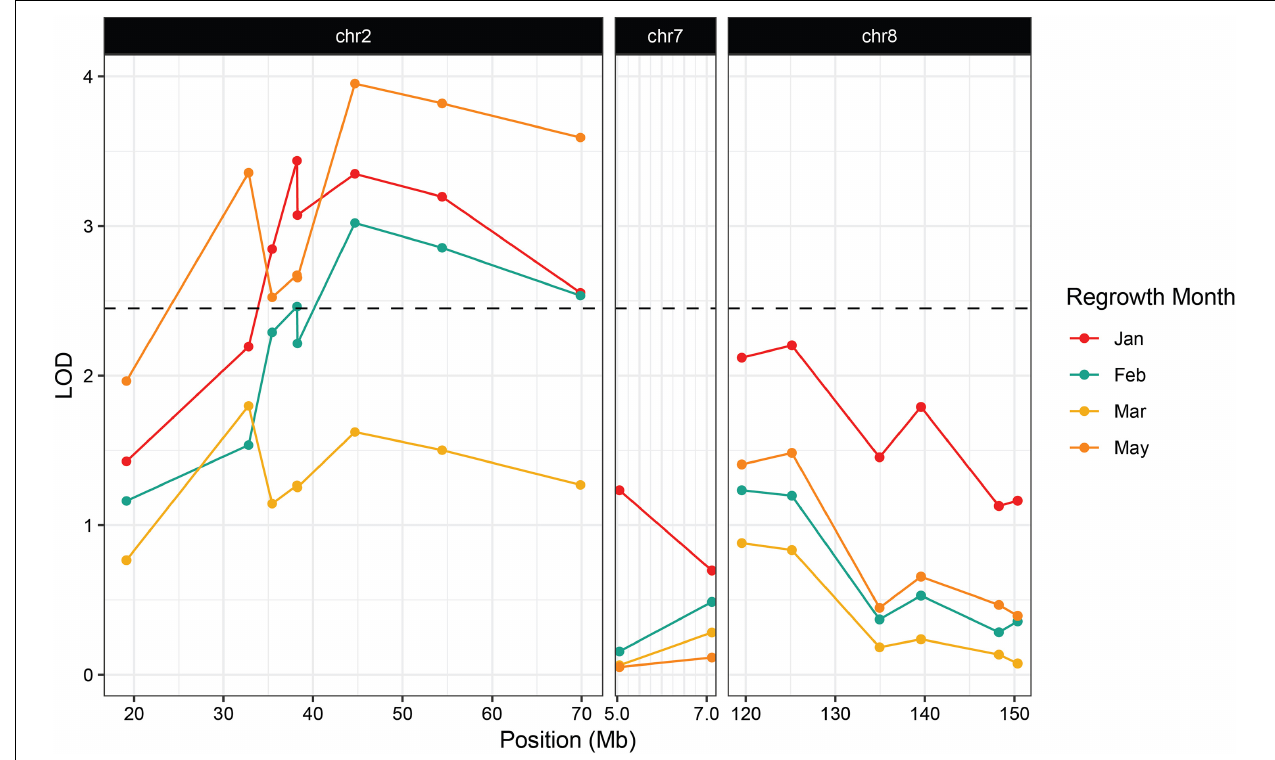
FIGURE 4 | Association between regrowth and markers on chromosomes 2, 7, and 8 in the 2019 Hp301/“Gigi” F 2 population. QTL were considered significant if the LOD score exceeded the 95% threshold determined by 1000 random permutations of the data for each trait. The threshold was calculated independently for each time point. May had the highest threshold of LOD = 2.45 and was used here as the significance cutoff (dashed